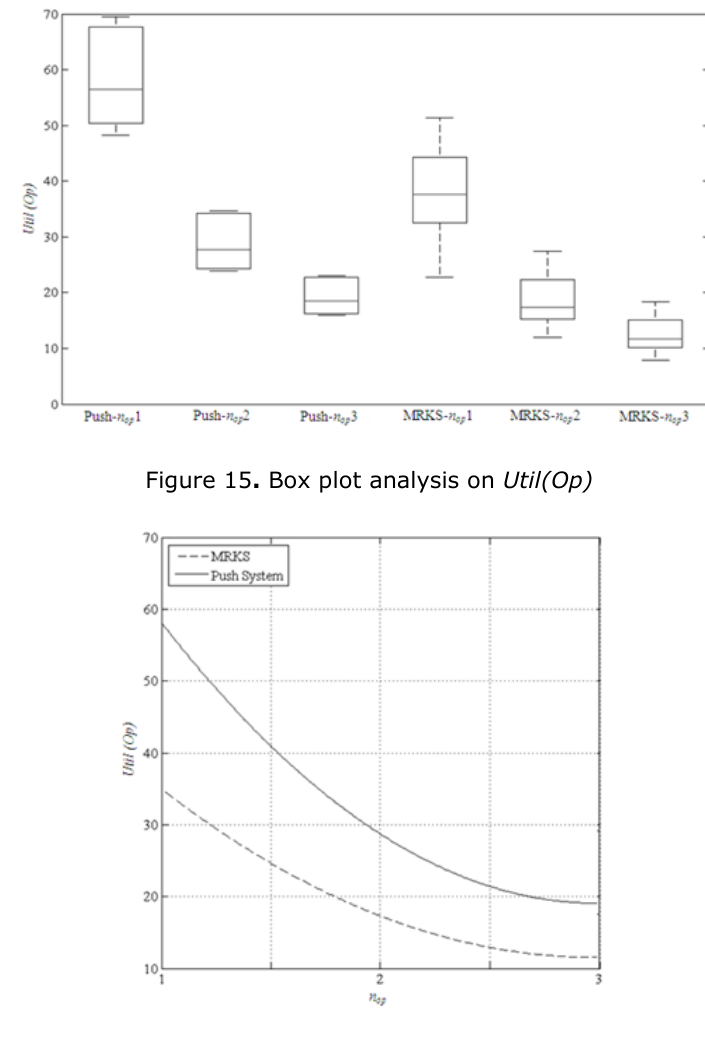
Figure 16. Effect of n op on operator